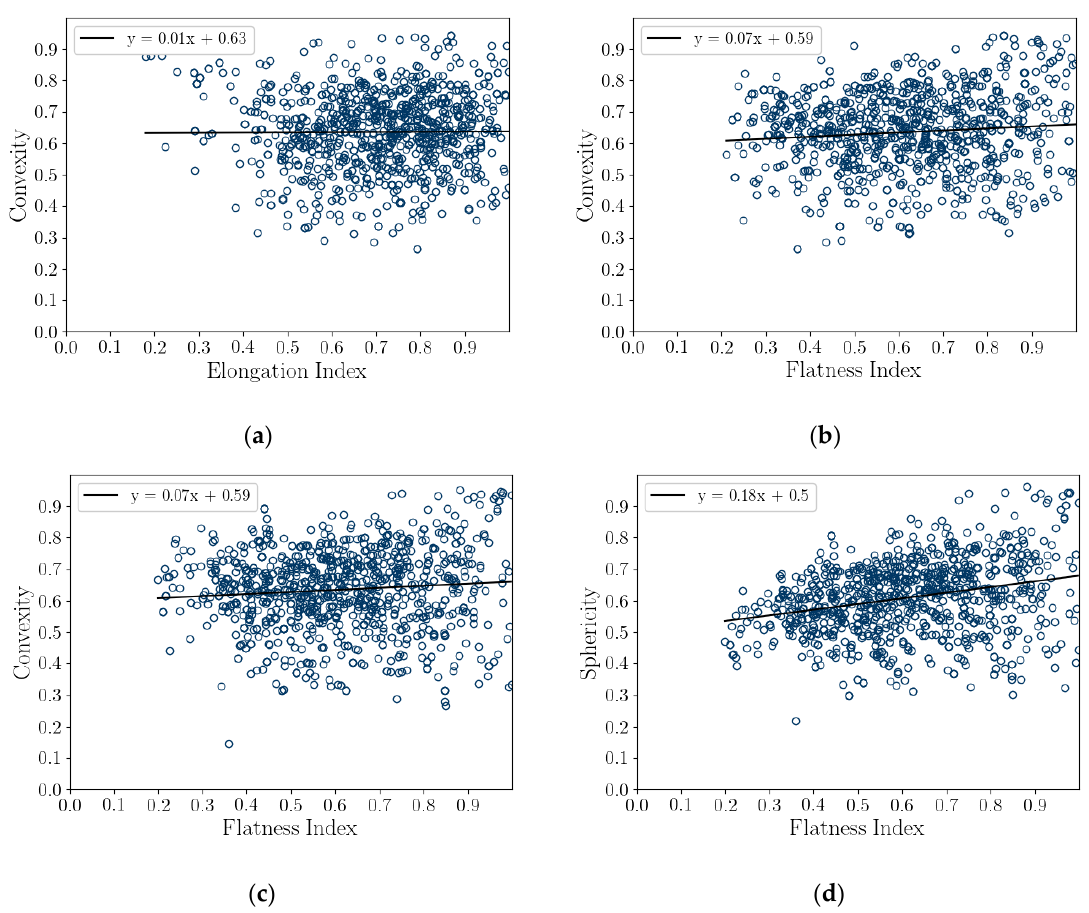
Figure 9. Correlation plots of 3D Feret dimension shape parameter with sphericity and convexity for 1000 random grains. Convexity versus elongation ( a ), convexity versus flatness ( b ), sphericity versus elongation ( c ), and sphericity versus flatness ( d ).